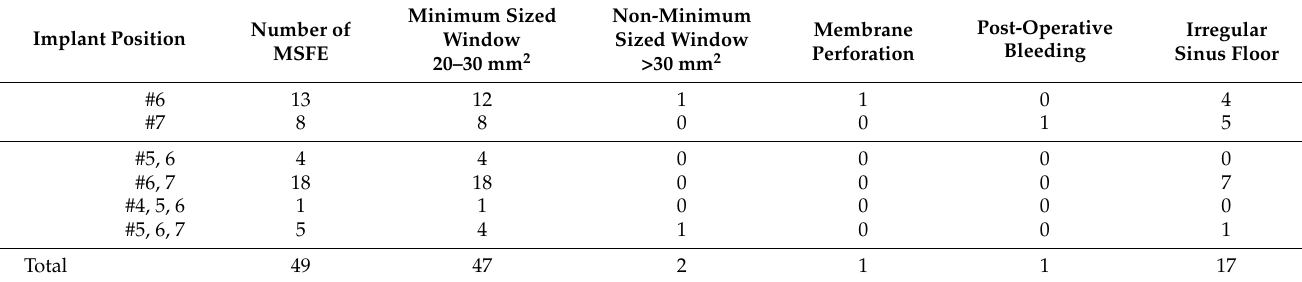
Table 1. The frequency of a non-minimum sized window, a membrane perforation, and a post-operative bleeding according to implant